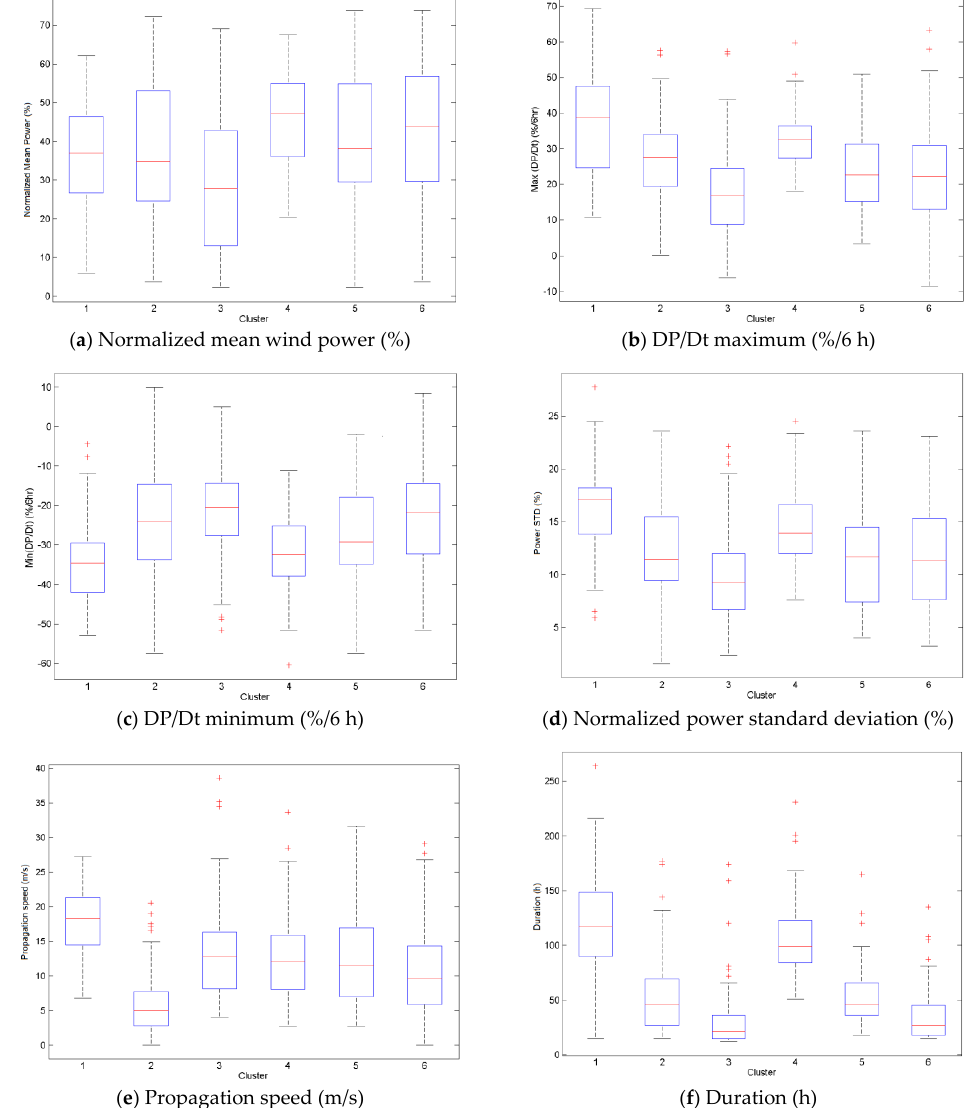
Figure 7 Main characteristics of the different trajectories clusters and their impact in the wind power production—Methodology 1.